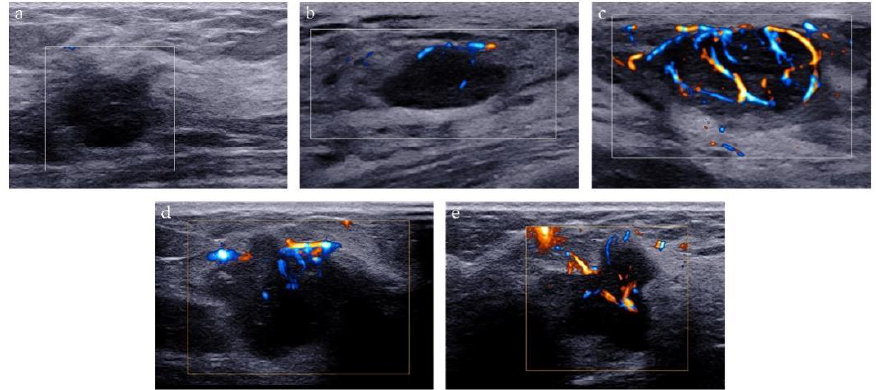
Figure 3. Microvascular distribution pattern of AP. ( a ) Non-vascular pattern; ( b ) Linear or curvilinear pattern; ( c ) Tree-like pattern; ( d ) Root hair-like pattern; ( e ) Crab claw-like pattern. The “stiff rim” sign is a color pattern on the SWE image and is of great help for differential diagnosis of breast tumors [24]. The “stiff rim” sign appears locally at the margin of the lesion and forms a closed circle (Figure 4a). As for quantitative evaluation of stiffness of lesions, we recorded the average measurements of E-max, E-mean, E-min, E-sd and E-ratio of breast lesions (Figure 4b,c). Their cut-off values were determined using receiver operating characteristic (ROC) curves